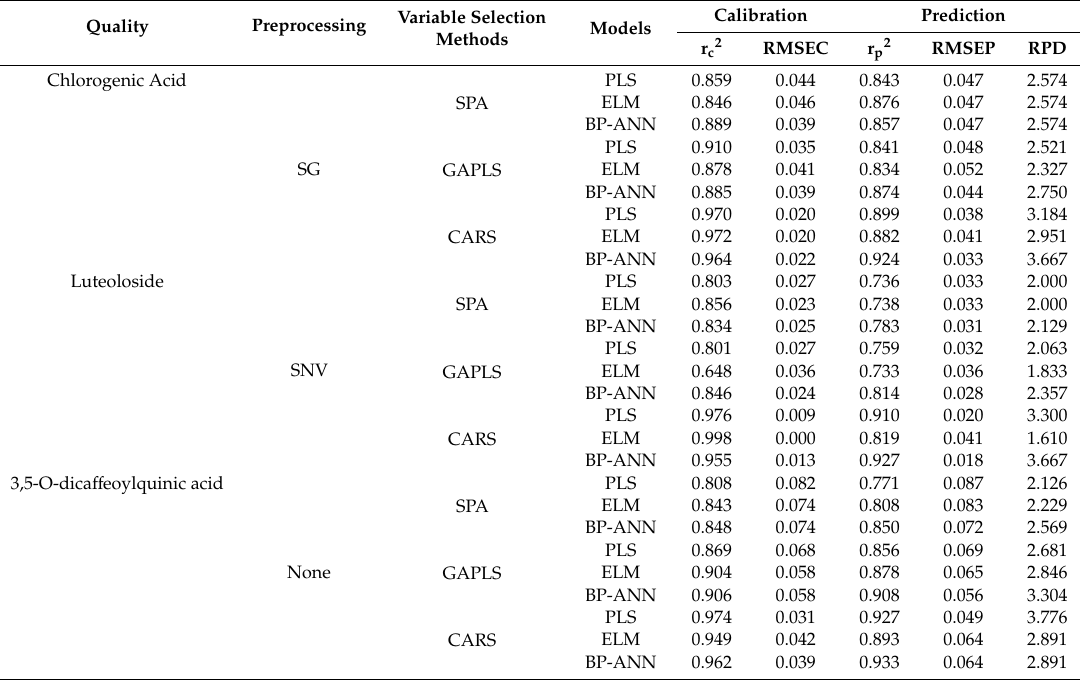
Table 3. Results of di ff erent regression methods based on sensitive variables for chlorogenic acid, luteoloside, and 3,5-O-dica ff eoylquinic